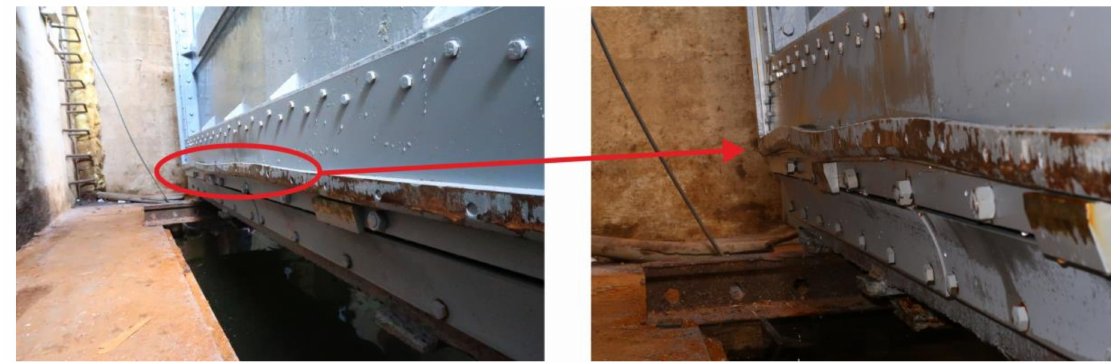
Figure 16. Deformed bottom part of the bronze sealing.